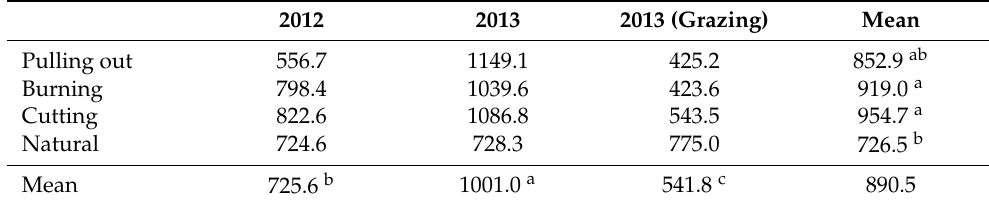
Table 3. Grazeable dry matter yield of improved and grazed rangeland (kg/ha).